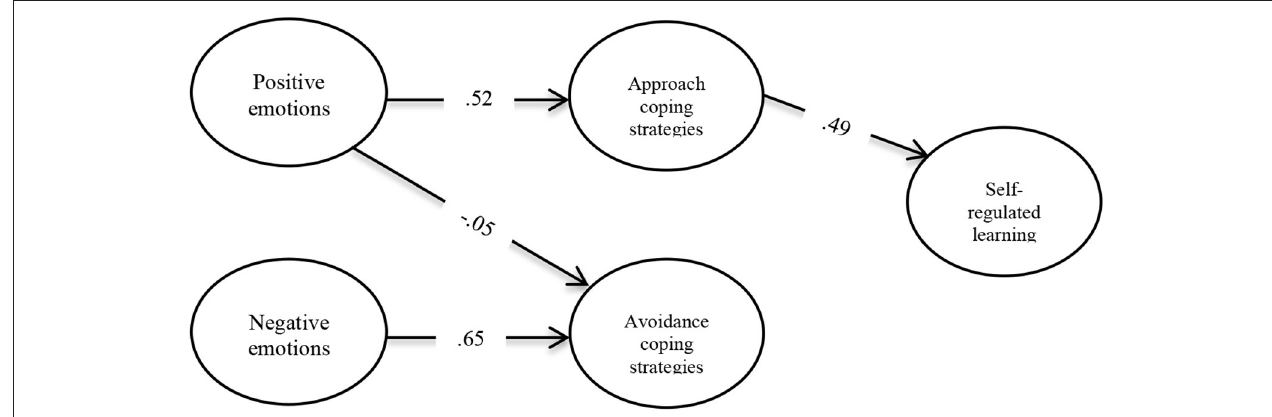
FIGURE 2 | Estimated mediation model of coping strategies between emotions and self-regulation of learning. All parameters were statistically significant at p < 0.001, except the effect of positive emotions and avoidance coping strategies, which was significant at p <